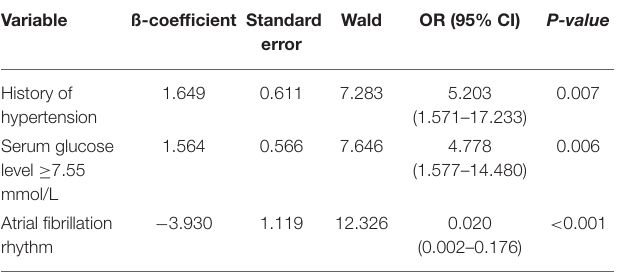
Frontiers in Neurology |